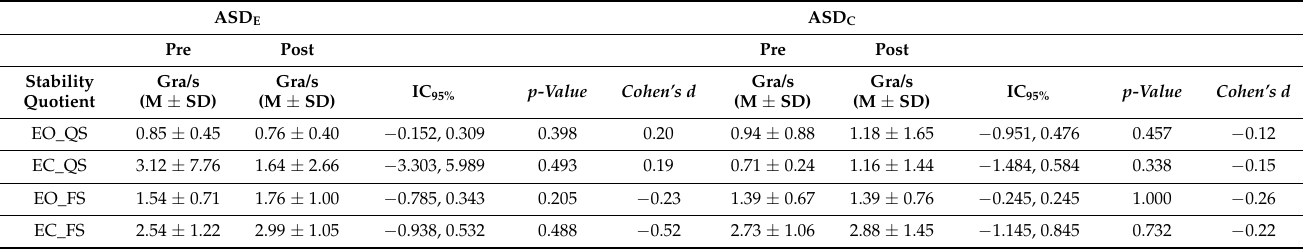
Table 3. Descriptive and statistical values for the CoP during EO_QS, EC_QS, EO_FS and EC_FS conditions by the ASD E and ASD C groups.